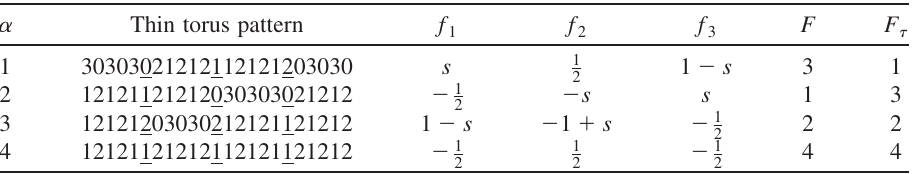
TABLE V. c ¼ 0 thin torus patterns for a three–domain-wall k ¼ 3 Read-Rezayi state, and the offset functions of those domain walls. The orbital positions 2 n offset functions for c ¼ 1 can be obtained by, respectively, shifting each pattern one orbital to the right and adding 1 to each offset